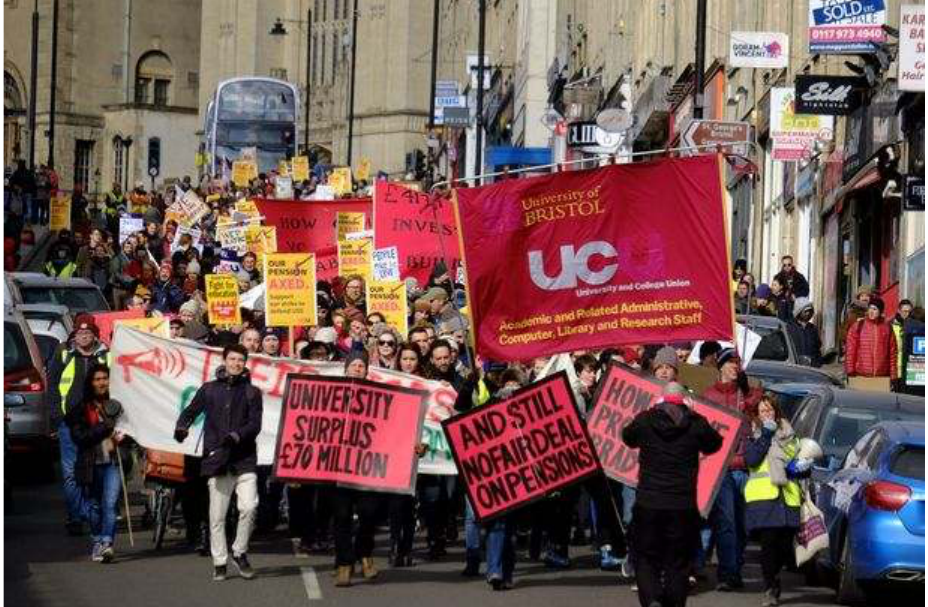
Figure 11. Staff and students march through Bristol, November 16, 2018